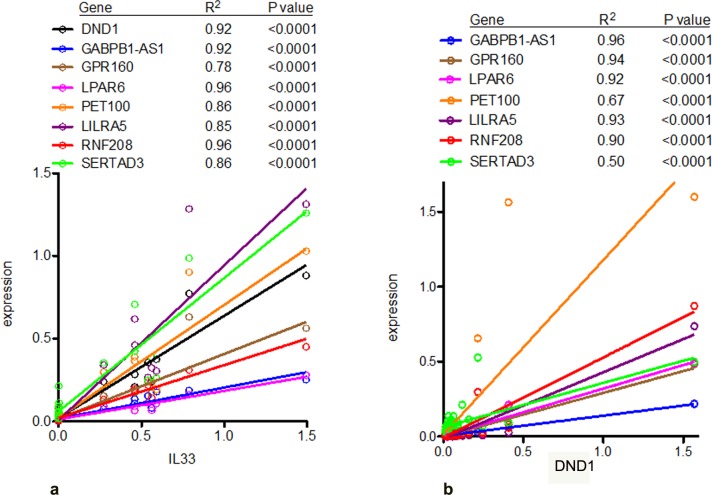
a)IL-33 levels are correlated with expression of multiple genes during MS relapse and remission. mRNA were sampled from the different groups outlined in Fig 2. Expression levels of IL-33 and the indicated genes were determined by PCR and normalized to levels of GAPDH. Correlations were determined by linear regression (R2). P-values are the probability that the slope of the line is non-zero. (b) DND1 levels are correlated with expression of multiple genes in patients with CIS. Expression levels of DND1 and the indicated genes were determined by PCR and normalized to levels of GAPDH. Correlations were determined by linear regression (R2). P values are the probability that the slope of the line is non-zero.